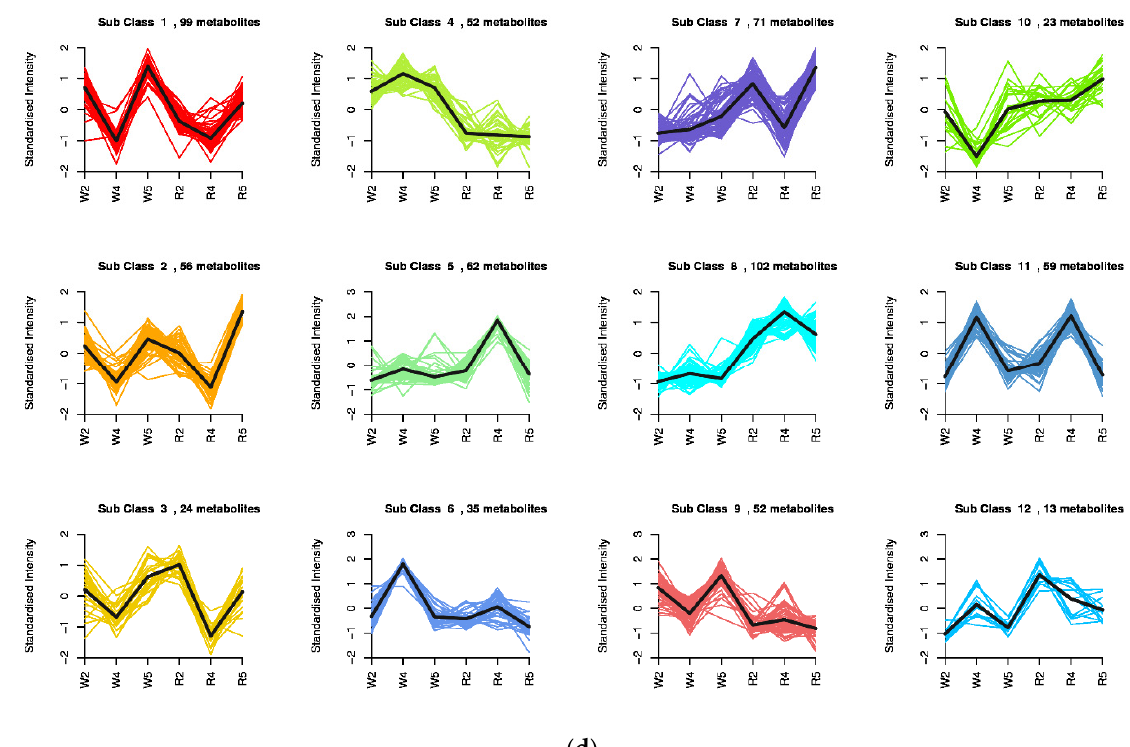
Figure 4. ( a ) PCA score chart of MS data for all QC samples and sample groups. ( b ) Venn diagram of DEMs in multiple pairwise comparisons of CK vs. LP. ( c ) Venn diagram of DEMs in multiple pairwise comparison of CK vs. HP. Each circle represents a comparator group, numbers in ellipse overlaps represent the number of DEMs common to the comparator group, and numbers outside overlaps represent the number of specific differential metabolites of the comparator group. ( d ) K-means diagram of DEMs. The X-coordinate represents the sample. The Y-coordinate represents the relative standardized metabolite content.